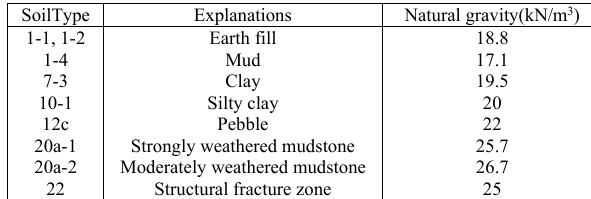
Table 2 . Soil type and property parameters in the original geological investigation report